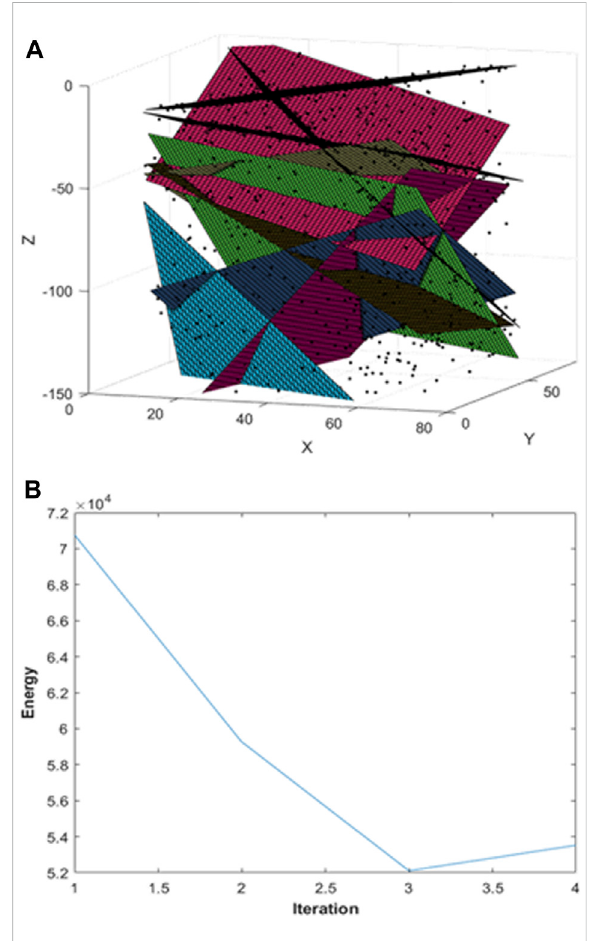
FIGURE 11 (A) Result of fracture modeling using the GARNET algorithm for data containing high noise levels and many outliers. (B) Energy values obtained after each iteration were minimized in the third